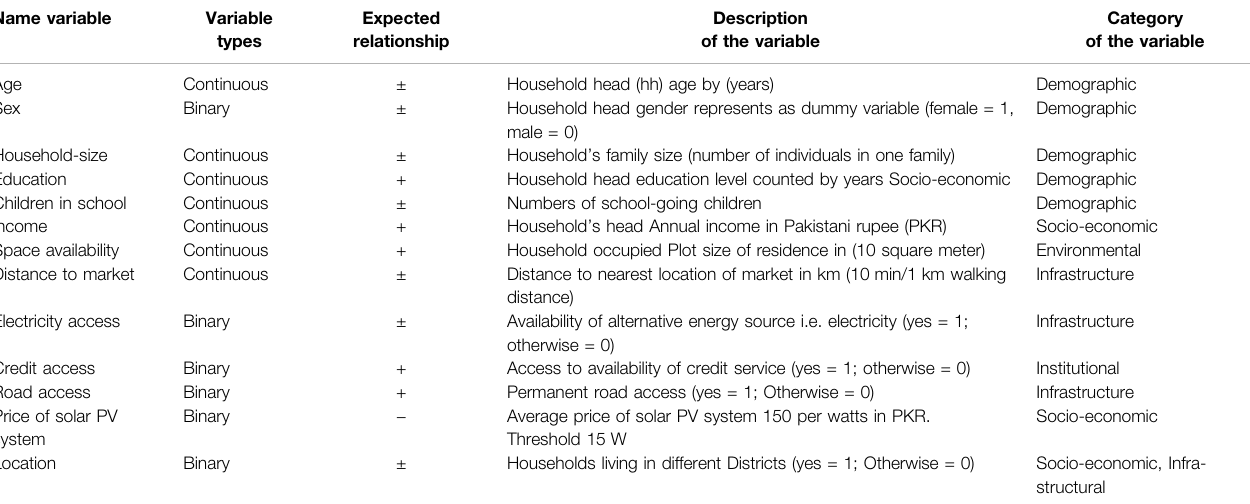
TABLE 1 | Description of explanatory variables used in the regression